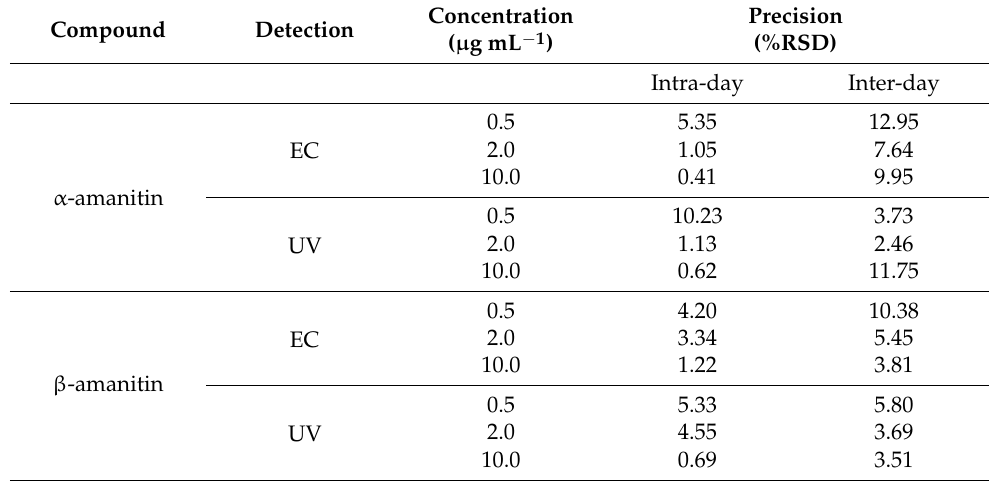
Table 4. Intra- and inter-day precision for values for α - and β -amanitin analyzed by HPLC-UV-EC. Compound